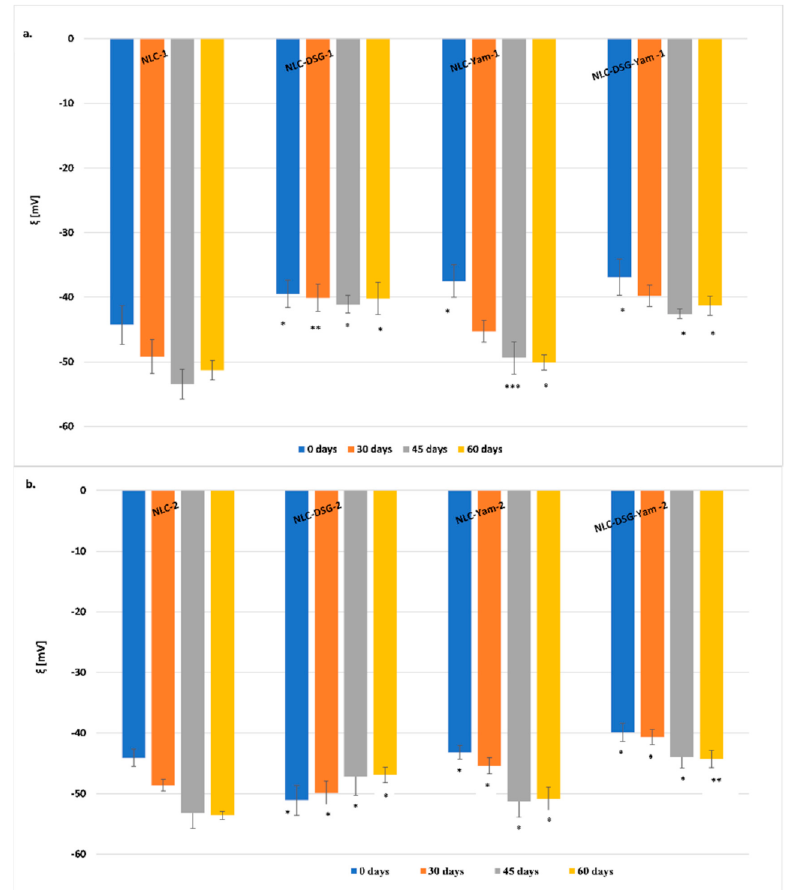
Figure 3. Variation over time in the physical stability of aqueous free- and co-loaded-NLC: ( a ) NLC-1 (prepared with evening primrose oil); ( b ) NLC-2 (prepared with soybean oil). * p < 0.05; ** p <